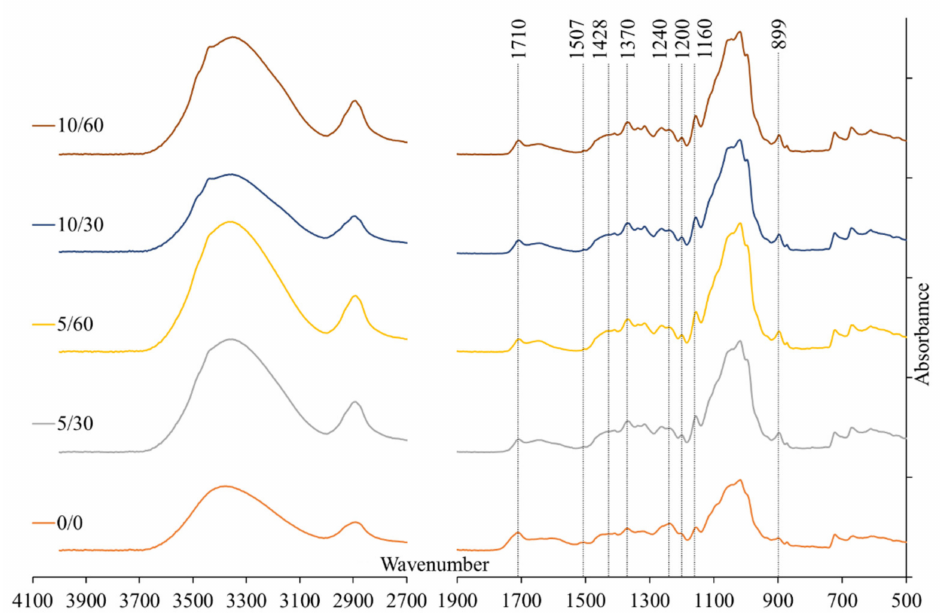
Figure 4. The FTIR spectra of the prepared membranes, recorded using the Perkin Elmer Frontier spectrometer with a universal ATR module of diamond crystal at a resolution of 4 cm − 1 in the absorbance